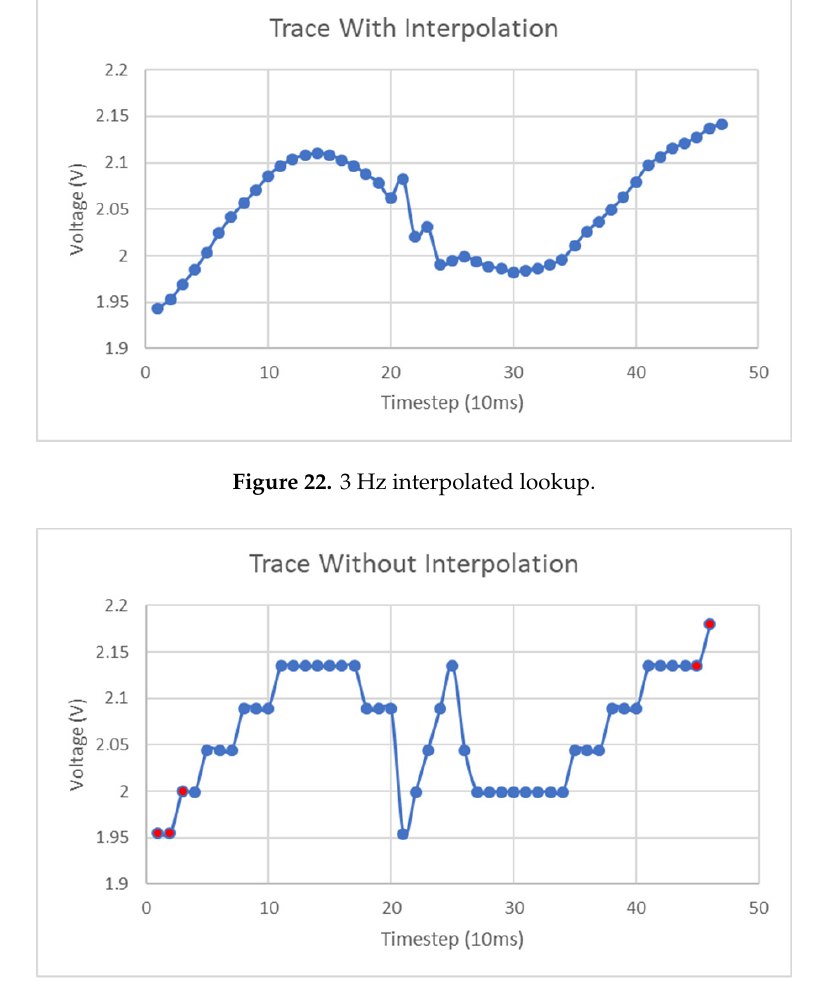
Figure 23. 3Hz first index lookup. Figure 23. 3 Hz first index